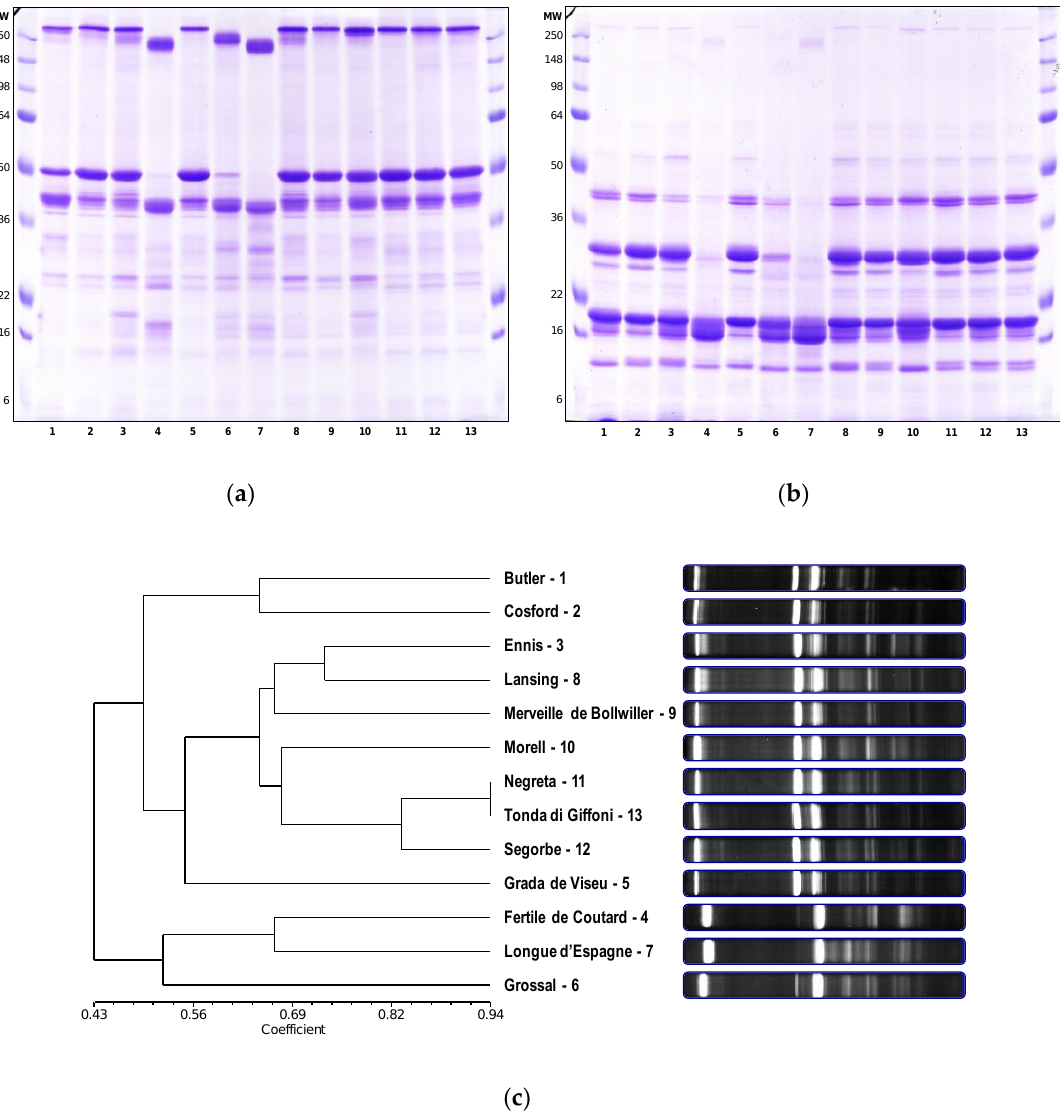
Figure 2. ( a ) Native and ( b ) reduced hazelnut protein electrophoretic profiles analyzed by SDS-PAGE using a 12% gel. Legend: lane 1, ‘Butler’; lane 2, ‘Cosford’; lane 3, ‘Ennis’; lane 4, ‘Fertile de Coutard’; lane 5, ‘Grada de Viseu’; lane 6, ‘Grossal’; lane 7, ‘Longue d’Espagne’; lane 8, ‘Lansing’; lane 9, ‘Merveille de Bollwiller’; lane 10, ‘Morell’; lane 11, ‘Negreta’; lane 12, ‘Segorbe’; lane 13, ‘Tonda di Giffoni’. Sizes (in kDa) of the protein molecular weight marker (SeeBlue™ Plus2 Pre-stained Protein Standard, Thermo Fisher Scientific, Massachusetts, USA) are shown on the left and right of the gel. ( c ) Dendrogram of genetic similarity among the 13 hazelnut varieties based on protein markers. The unweighted pair group method with arithmetic mean was calculated with the Jaccard’s similarity coefficient. The cophenetic correlation coefficient (r) for this matrix was 0.846.